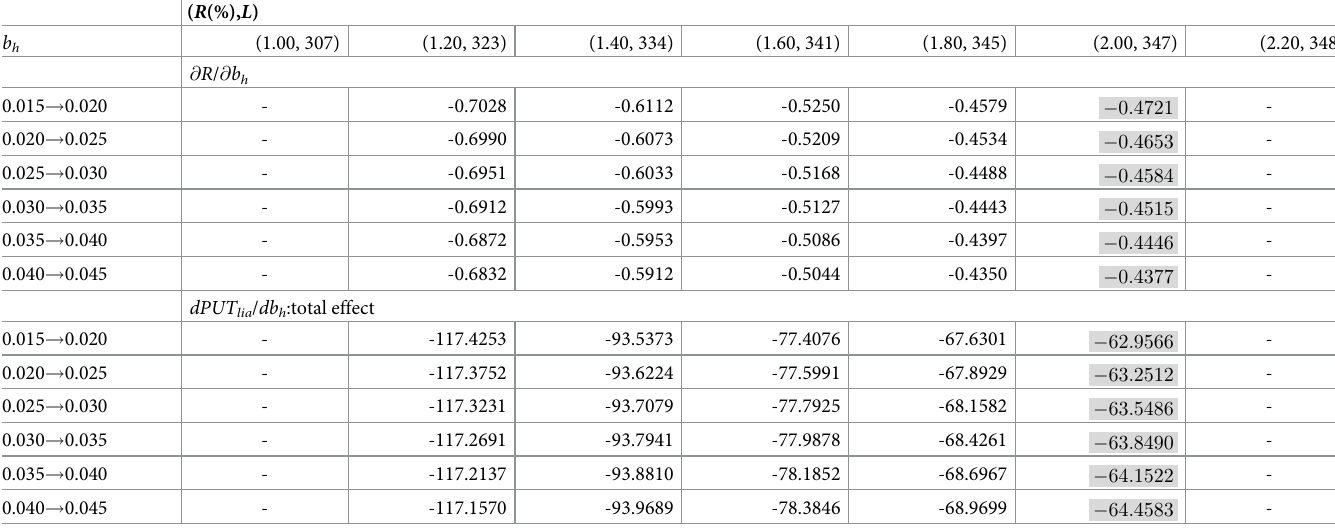
Note: Unless otherwise indicated, the same as Table 1. In the lower panel, the direct and indirect effects are adverse.